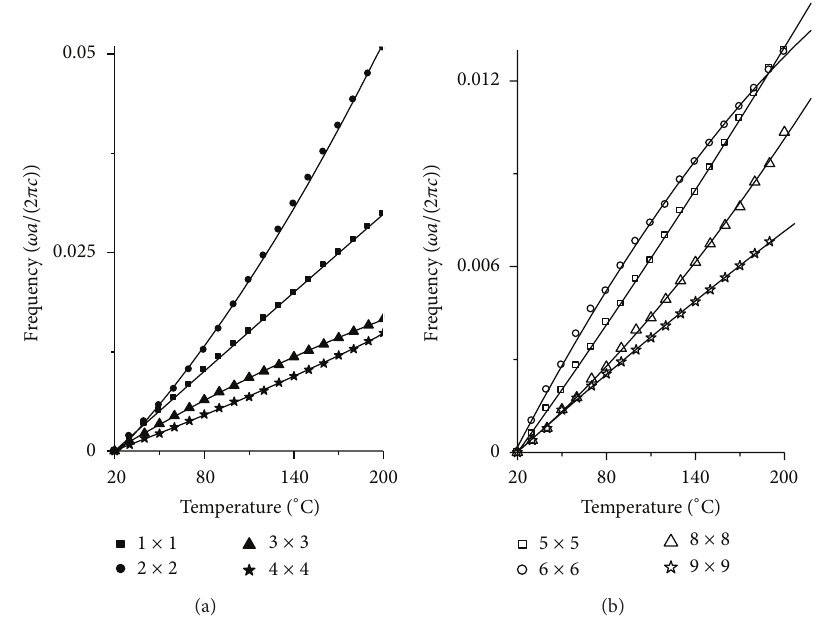
Figure 6: The shifted curves with the biggest average normalized power spectrum for 𝑛 × 𝑛 cavity, which give the relation between resonant frequency and temperature. The real lines in (a) and (b) represent the polynomial fit results. (a) is the result for 1 × 1 to 4 × 4 cavity. (b) is the result for 5 × 5 , 6 × 6 , 8 × 8 , 9 × 9 cavity.